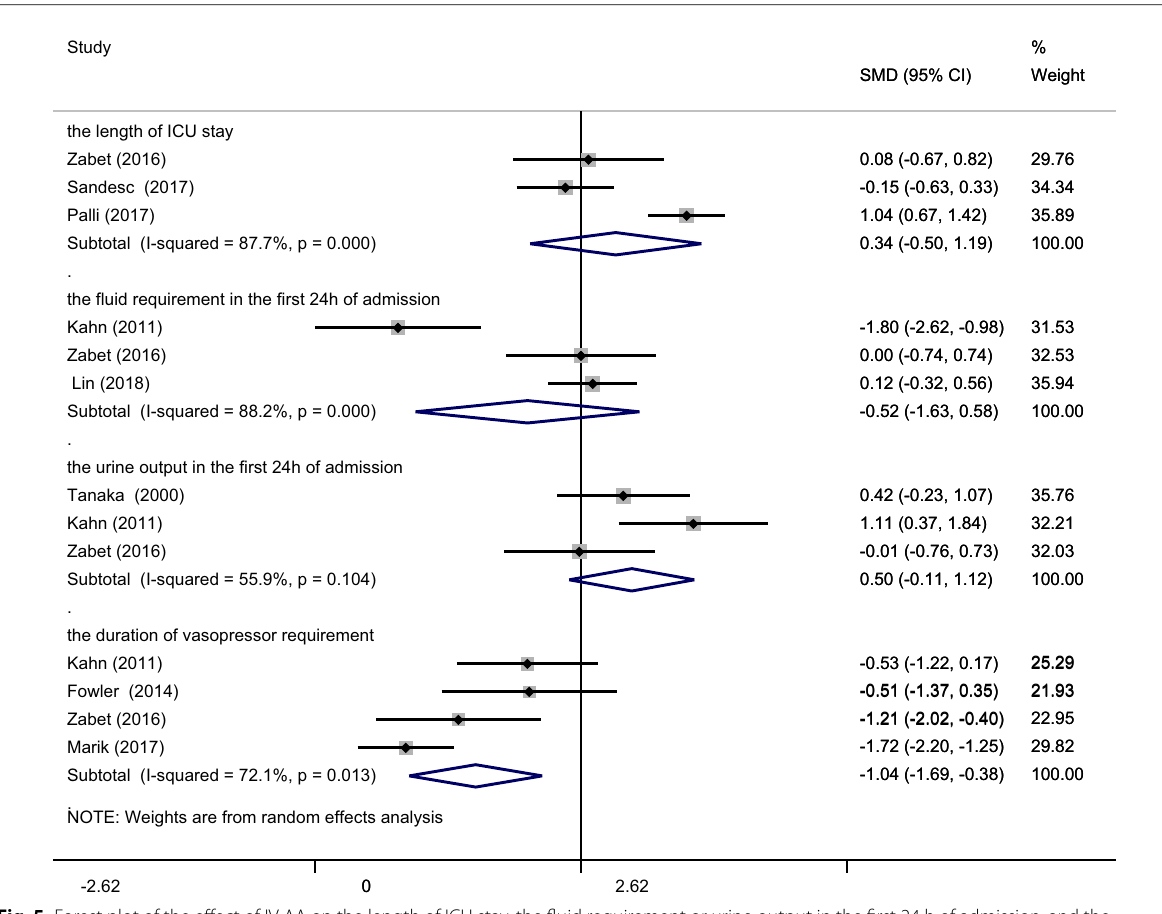
Fig. 5 Forest plot of the effect of IV AA on the length of ICU stay, the fluid requirement or urine output in the first 24 h of admission, and the duration of vasopressor